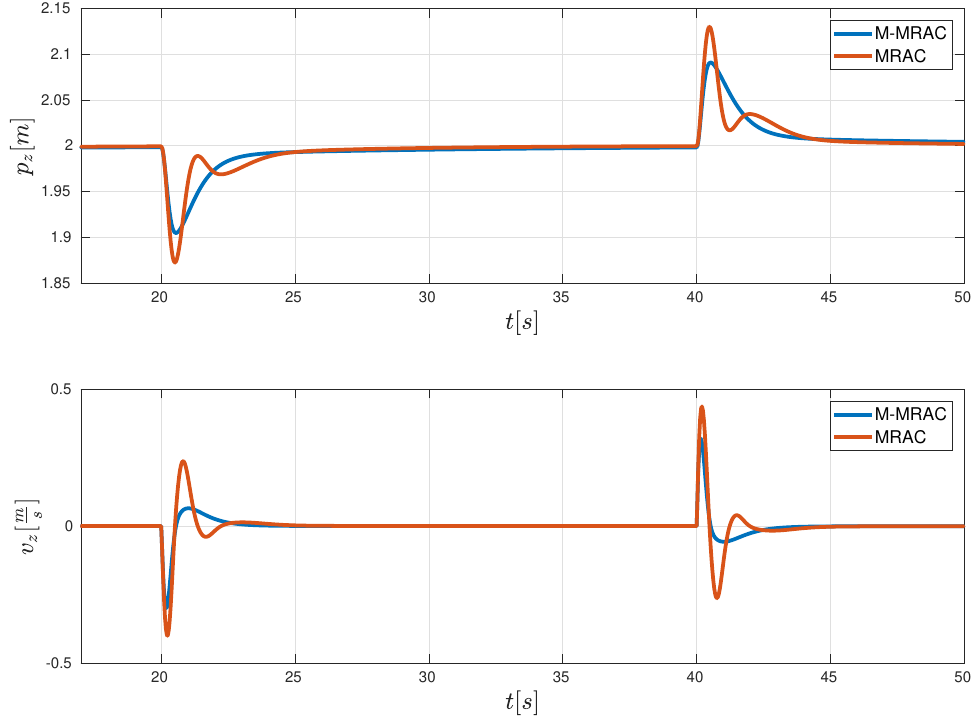
Figure 5. Simulation of the difference of the additive PID